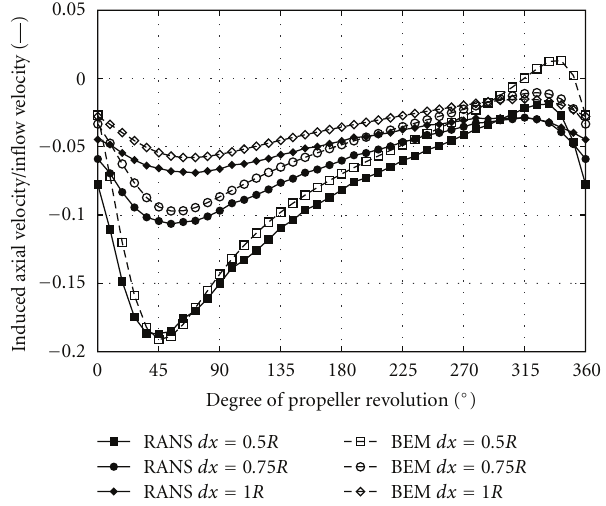
Figure 9: Comparison of the normalised induced axial velocities for di ff erent axial distances between the velocity transfer plane and the propeller (explicit coupling: r/R = 0 . 7, J = 0 . 5, and dt · n = 3 . 78 ◦ ).